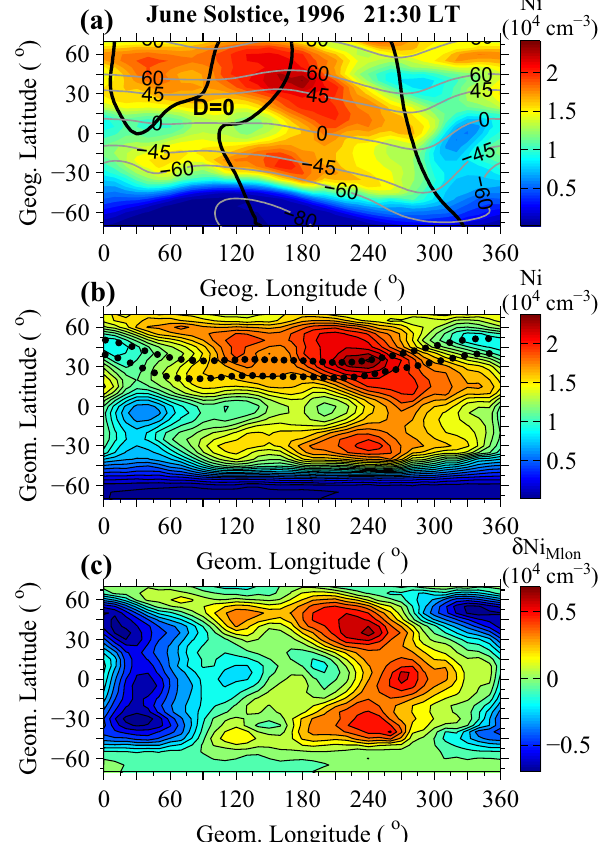
Fig. 1. (a) Longitude and latitude variations of DMSP F12 N i measured at nightside 21:30 LT around the June Solstice of 1996. The thick black lines denote that geomagnetic declination is zero and the thin gray lines are geomagnetic inclination isolines. (b) The distribution of N i in geomagnetic coordinates. Two black dotted lines denote the solar terminators at 300 km height at 21:30 LT (the upper line) and 20:30 LT, respectively. (c) N i longitude fl uctuations with longitudinal averages removed for each geomagnetic